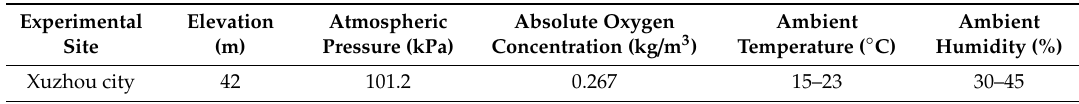
Table 1. Experimental environmental